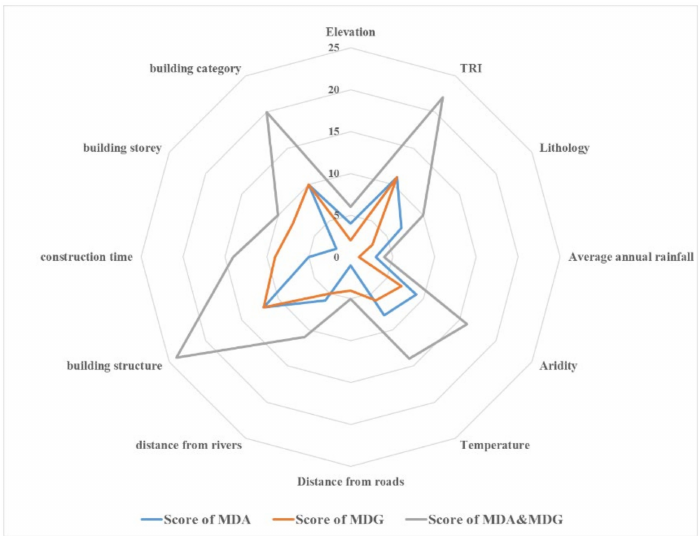
Figure 7. Impact factors’ assignment score